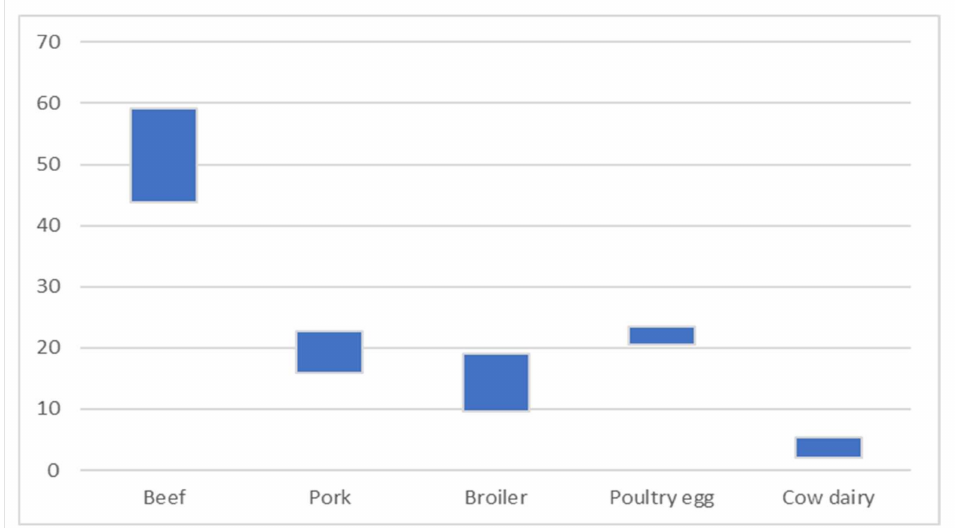
Figure 1. Range of energy inputs of studies covered in this review according to species